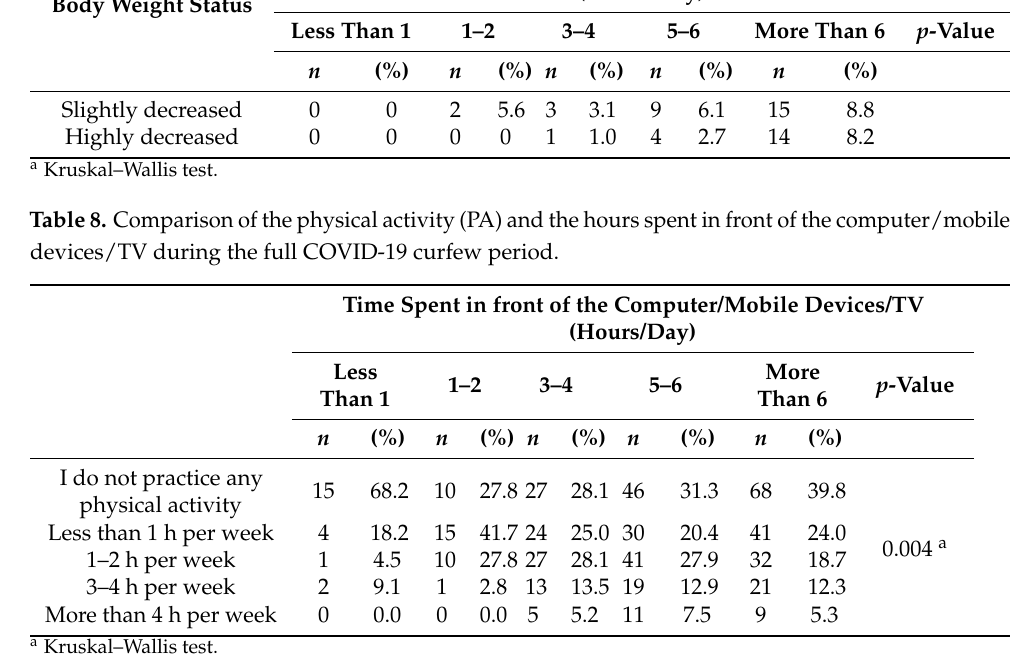
Table 9. Comparison of the homemade meals per week and ordering from a restaurant, takeaway, and deliveries per week during the full COVID-19 curfew